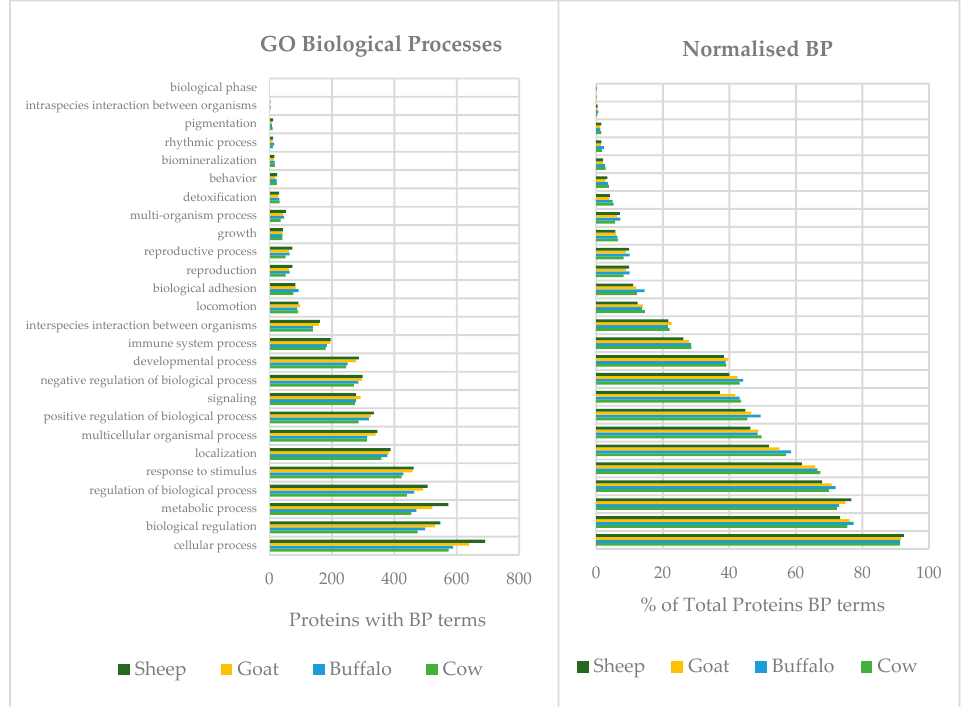
Figure 3. Summary of Biological Process (BP) terms of protein groups from analysis of cream from four species, with absolute numbers ( left ) and normalised to the total number of annotated proteins ( right ).